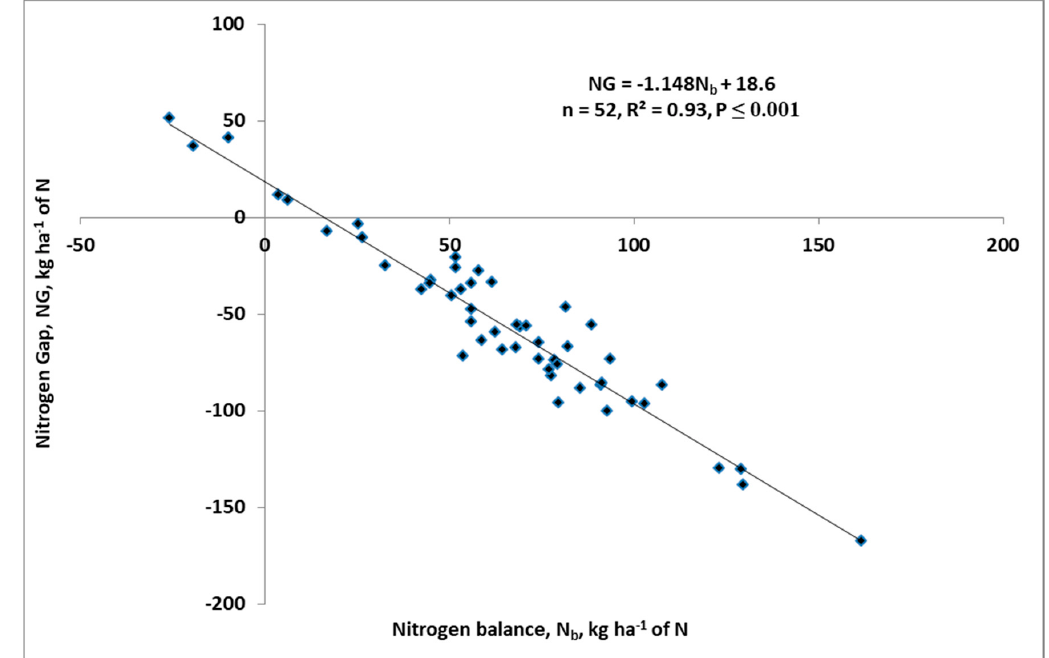
Figure 8. Effect of nitrogen balance in WTR on the nitrogen gap variability.